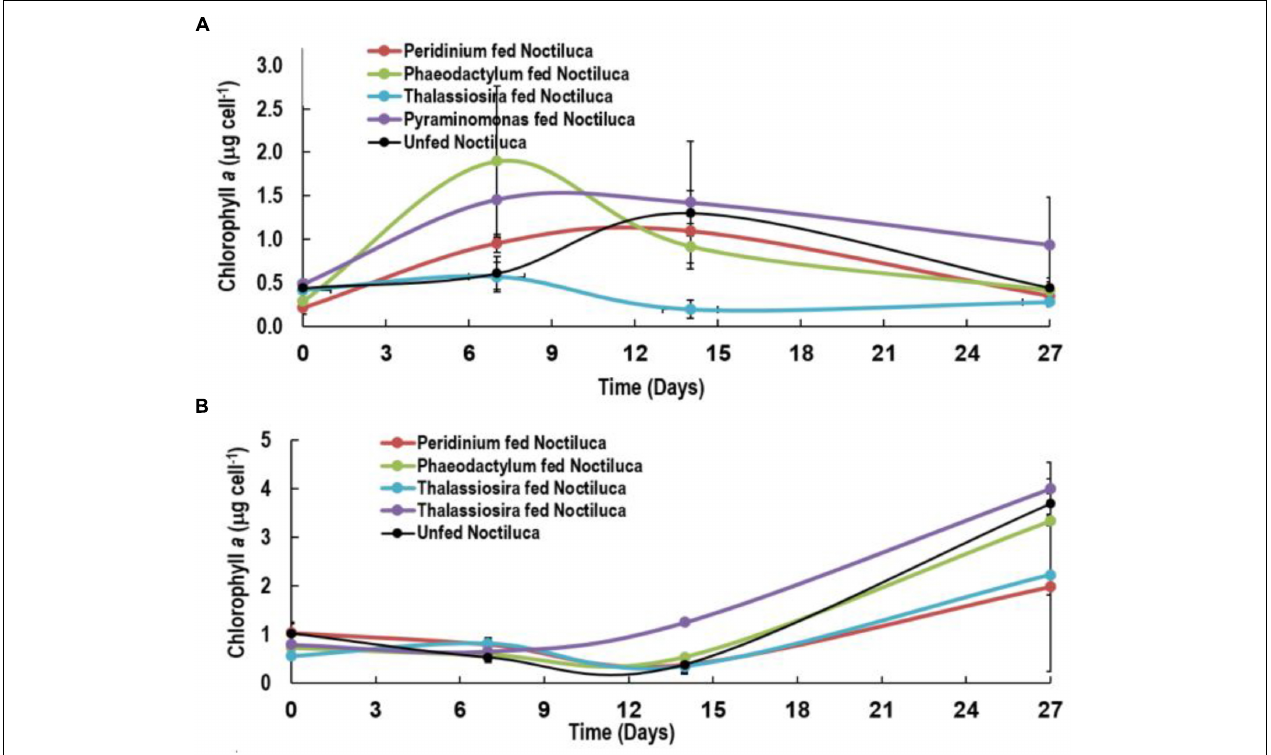
FIGURE 4 | Intracellular Chlorophyll a concentrations of Noctiluca ( µ g Noctiluca cell - 1 ) for unfed Noctiluca and for Noctiluca fed with P. foliaceum , P. tricornutum , T. weissflogii , and Pyraminomonas sp. for (A) optimal (250 µ E m - 2 s - 1 , HL) and (B) low light (10 µ E m - 2 s - 1 , LL) exposed cultures. Data points represent means ± SE ( n =